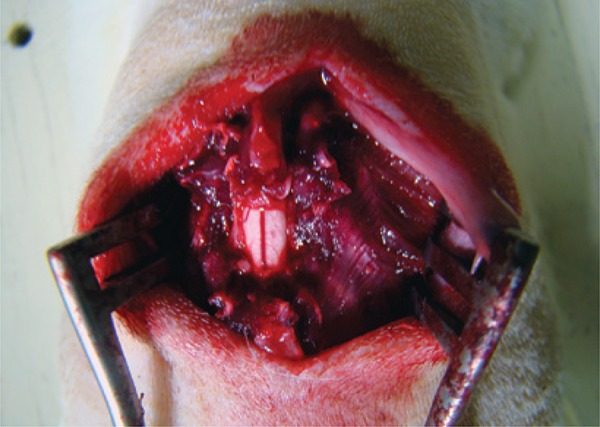
Exposição cirúrgica da medula espinal